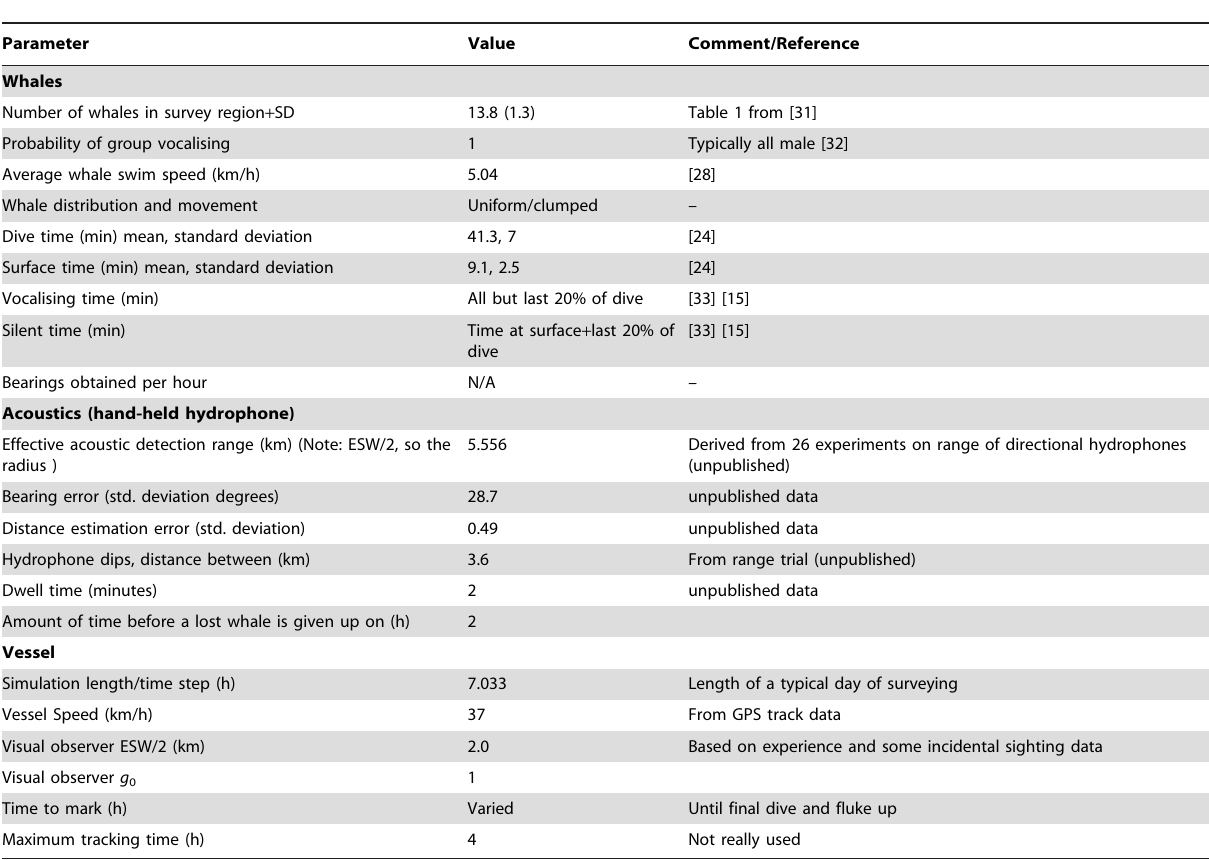
Table 1. Parameters for the validation study on sperm whales in Kaikoura, New